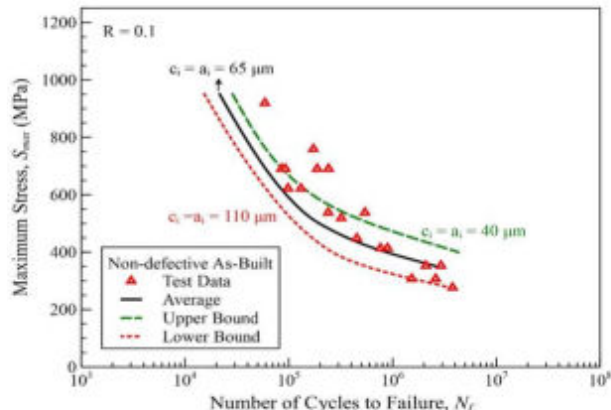
Figure 11. Experimental data and predicted fatigue lives for average curve, lower and upper bounds of L-PBF Inconel 718 in as-built surface condition. Reprinted with permission from ref. [70]. 2018,